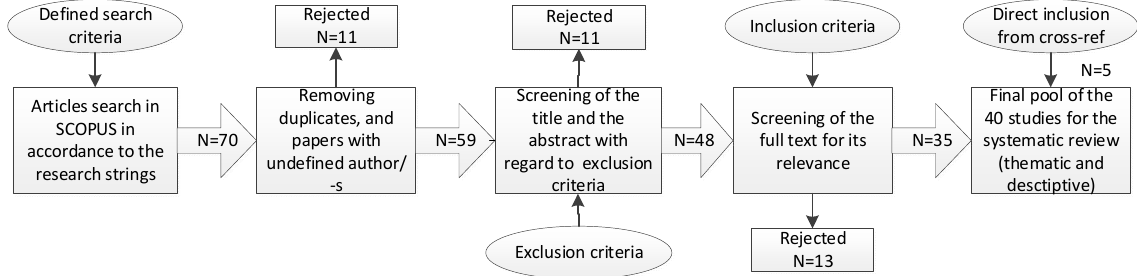
Figure 2. The overview of the process of papers selection and evaluation.